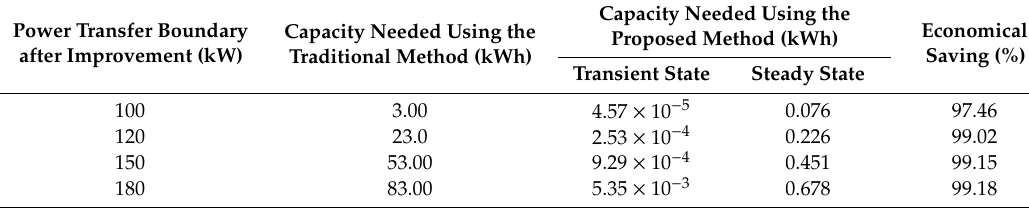
Table 3. Energy capacity comparison of batteries of the ESS (Run for 1